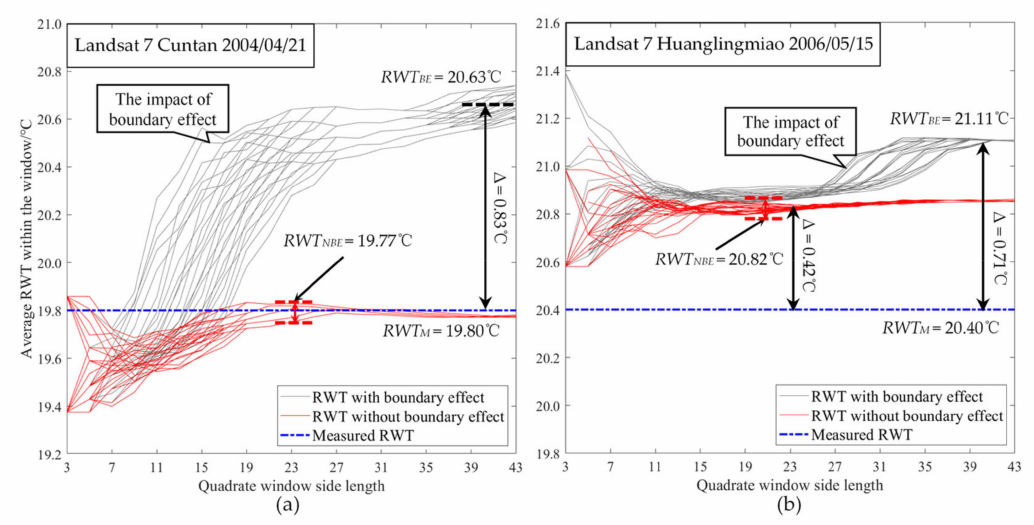
Figure 4. Impact of the boundary effect on Landsat 7 ETM+-derived river water temperature (RWT) for ( a ) Cuntan 2004/04/21 and ( b ) Huanglingmiao